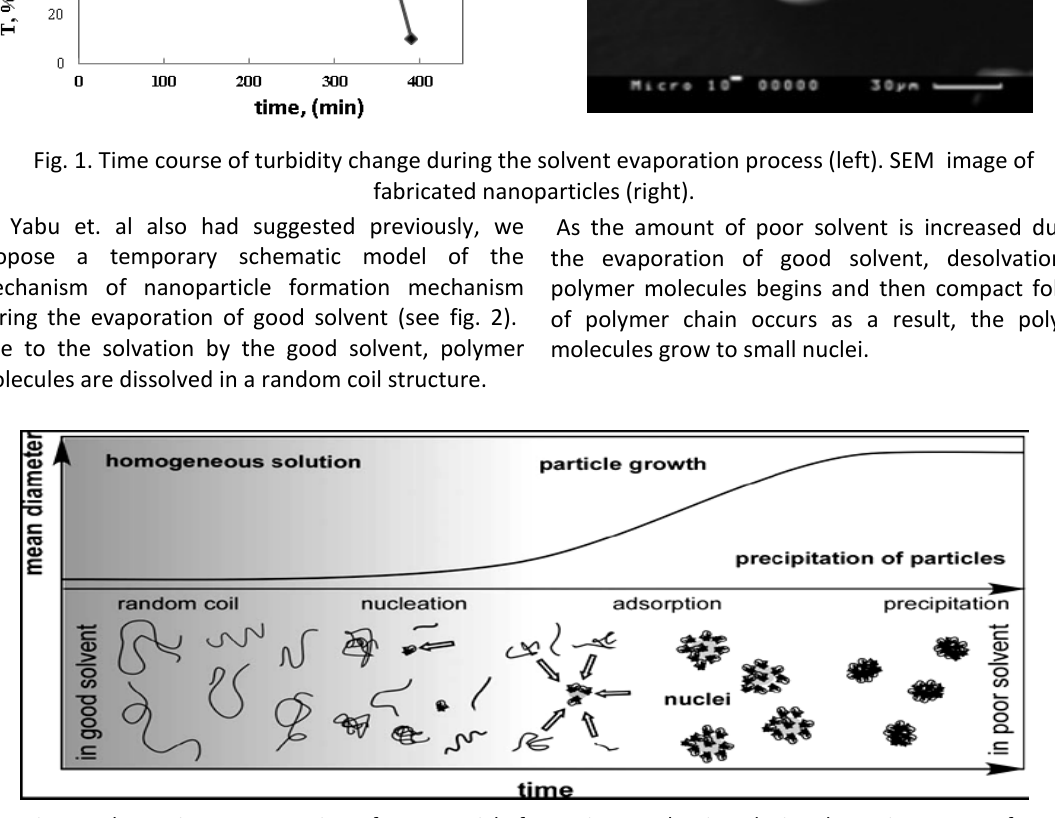
Fig. 2. Schematic representation of nanoparticle formation mechanism during dynamic process of solvent